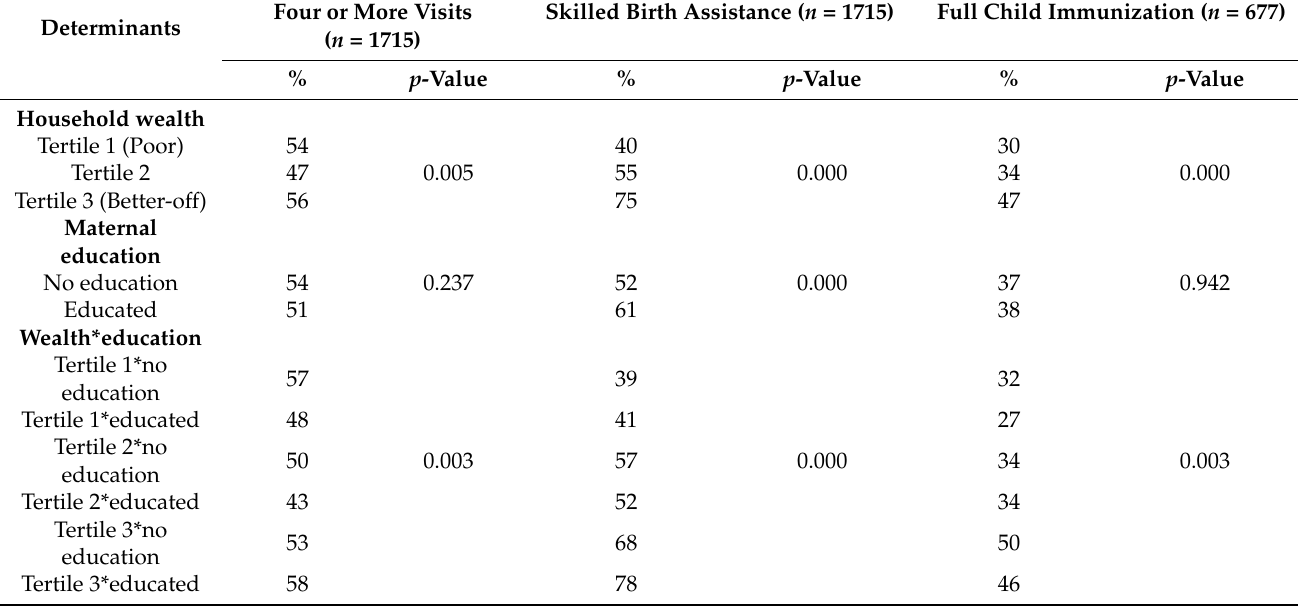
Table 2. Utilization of maternal, newborn and child health services by household wealth, maternal education and their